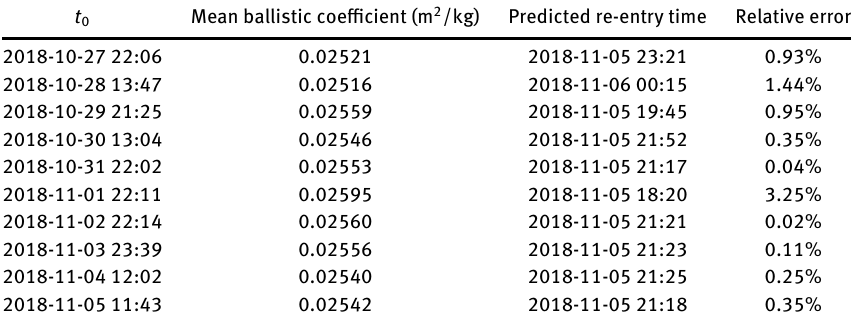
Table 3. Mean ballistic coeflcient and predicted re-entry time of Iridium-52